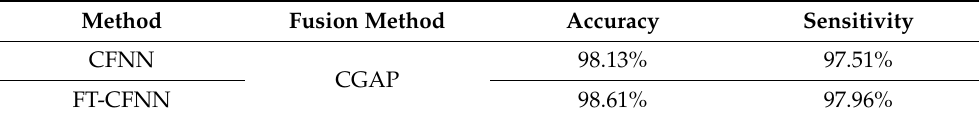
Table 10. Accuracy and sensitivity values obtained with the CFNN and